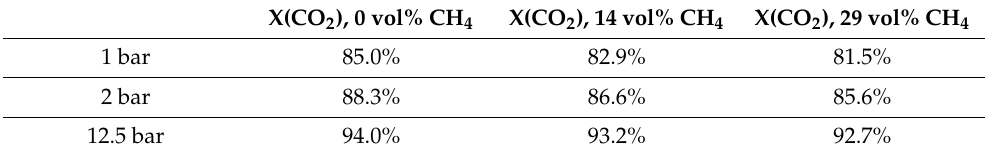
Table 11. Calculated CO 2 conversion in equilibrium for methanation with 0, 14 or 20 vol% CH 4 in the feed, based on an Aspen Plus simulation with a Gibbs reactor at 350 ◦ C, a feed with H 2 /CO 2 = 4 and N 2 addition as described in